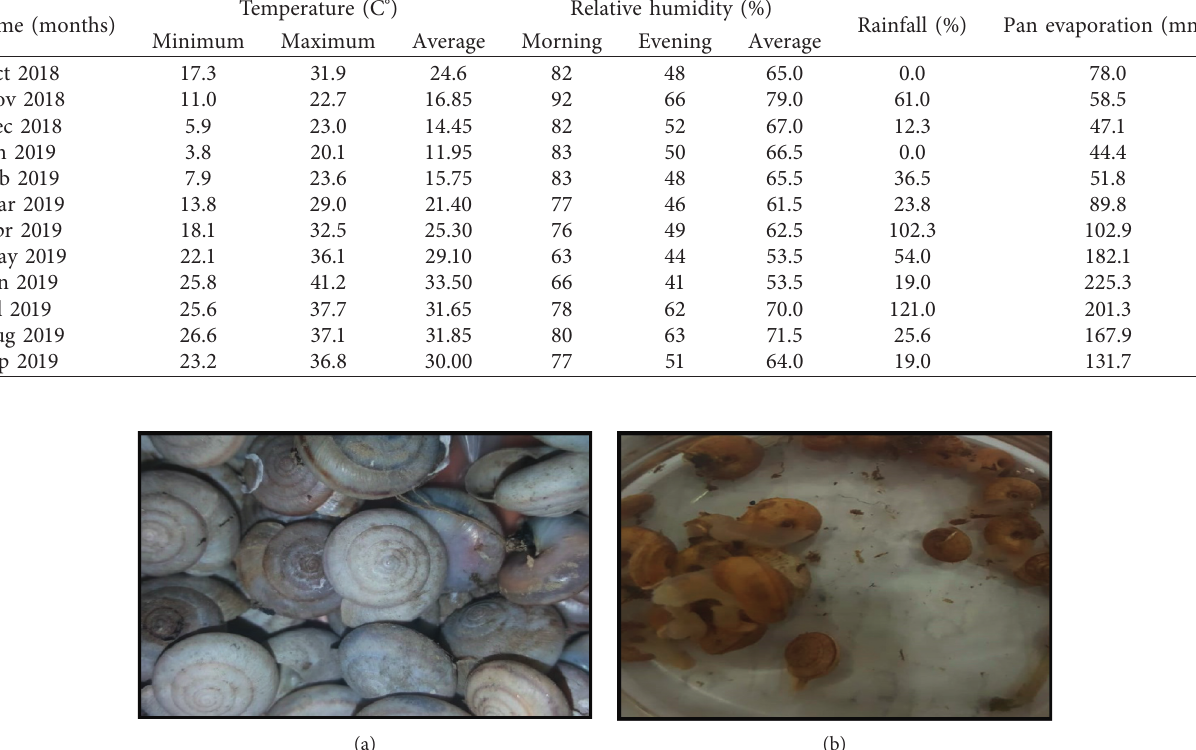
Figure 1: Snails belonging to the genera Indoplanorbis collected during the study for the investigation of the prevalence of Paramphistomum spp. cercariae (collection site: adjacent area of the river in district